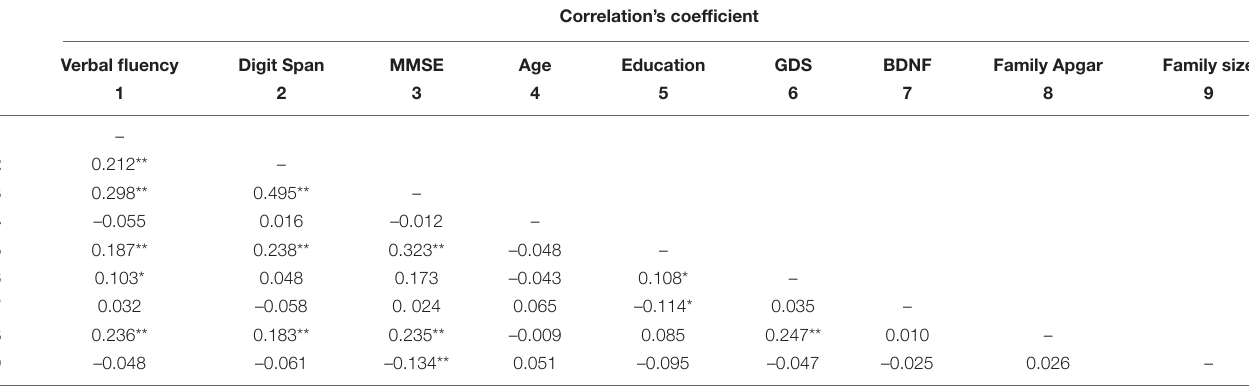
TABLE 3 | Pearson’s correlation coefficients between Family APGAR, BDNF, cognitive performance and potential covariates.